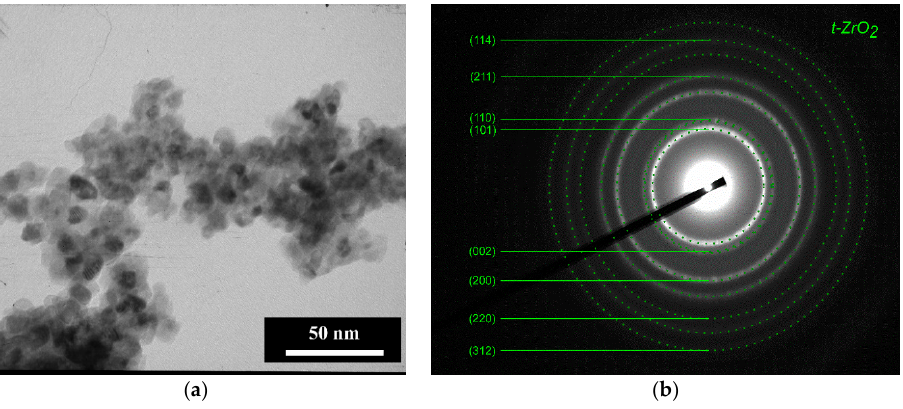
Figure 1. TEM image of pure 3Y-TZP-Al 2 O 3 powder (composition I) ( a ) and ED with Miller indexes ( b ).